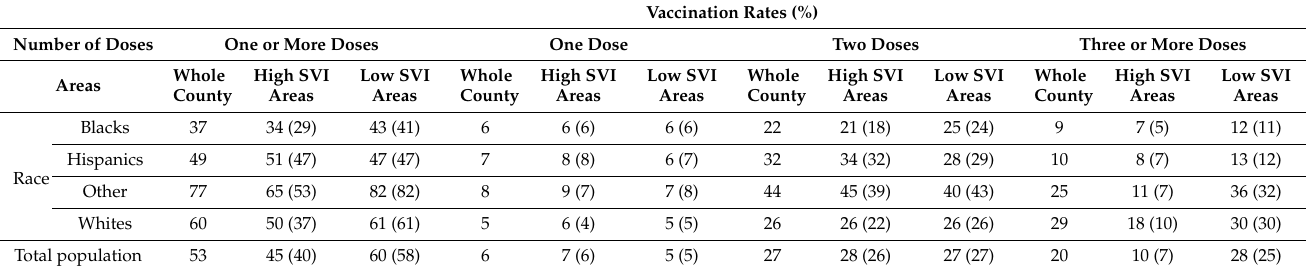
Table 2. Vaccination rates (%) by race/ethnicity and number of doses in the whole Milwaukee County and in areas of high and low social